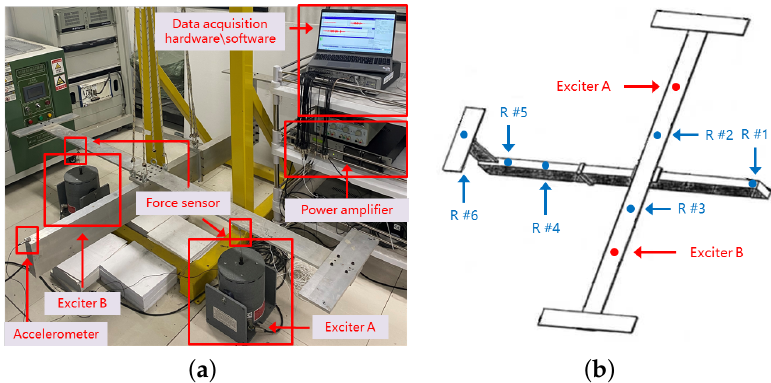
Figure 3. The self-built GARTEUR aircraft model and equipment for data collection. In the system, two exciters with two force sensors, six response accelerometers are used. The system is synchronized by the data acquisition hardware. The positions of two exciter and six acceleration measurement points are also given. ( a ) The self-built GARTEUR aircraft model used for data collection. ( b ) The positions of exciters and measurements points (R in